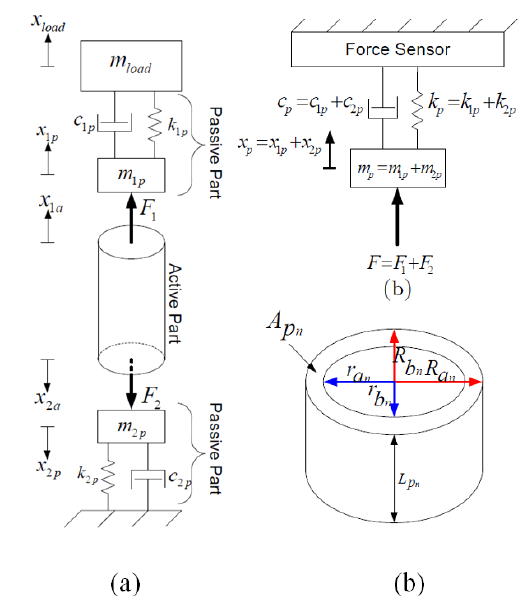
Figure 9: (a) Model of the Actuator showing the ac- tive and passive parts (b) combining top and bottom mass-spring-damper systems of pas- sive parts.